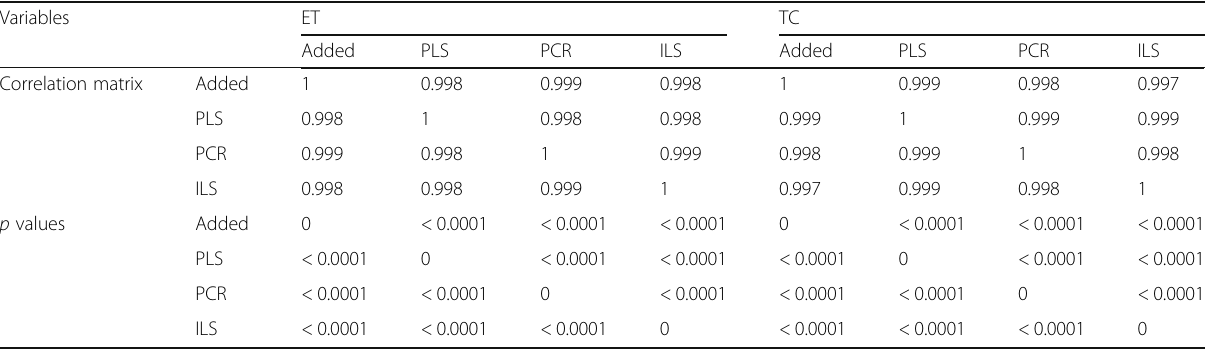
Table 3 Correlation matrix and p values via Pearson for ET and TC Variables Correlation